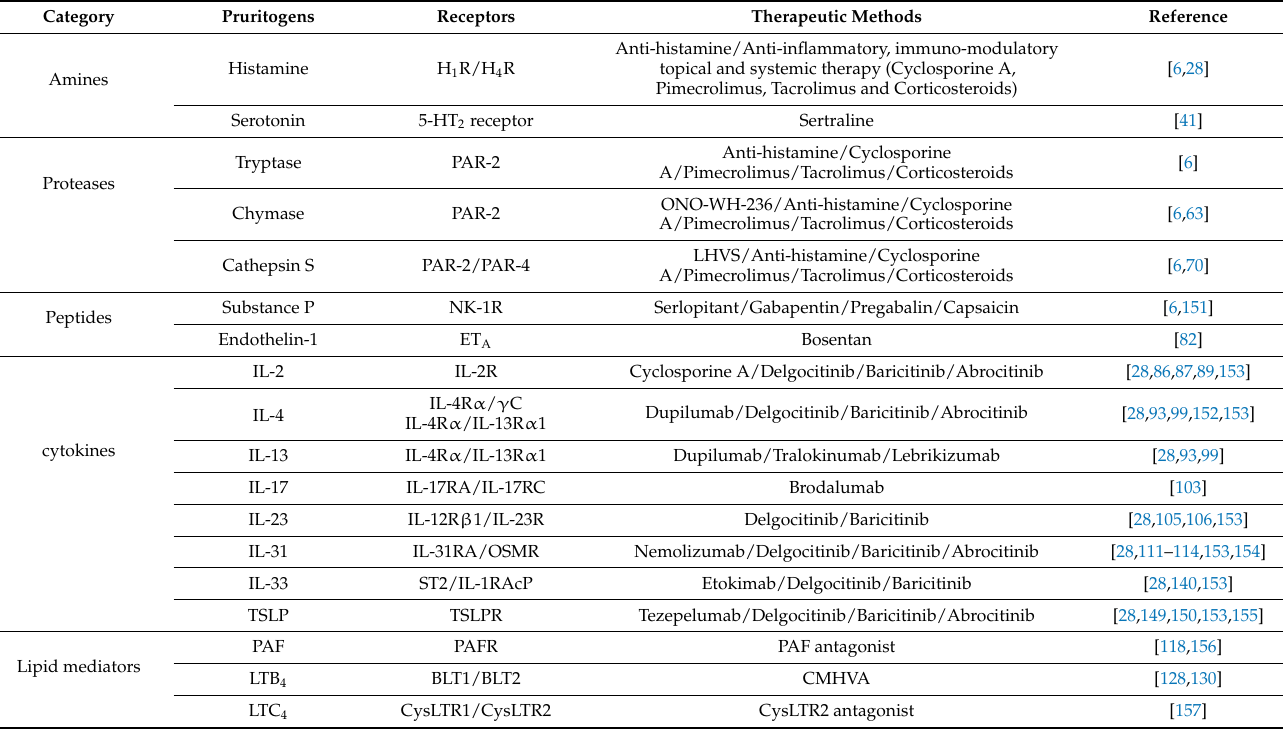
Table 1. Immune cell-derived itch mediators and therapeutic methods.